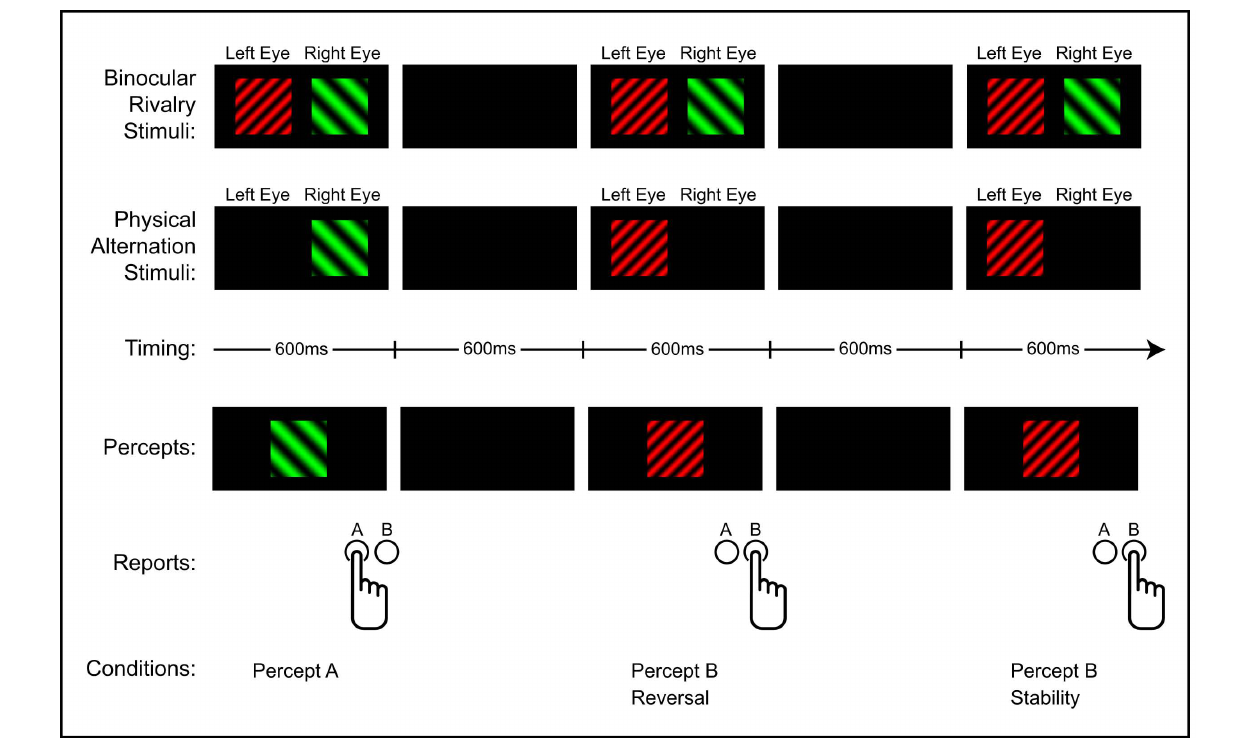
FIGURE 1 | Example of the intermittent paradigm. By presenting stimuli under binocular rivalry and physical alternation conditions and instructing subjects to report their percepts on each trial, all four types of comparisons